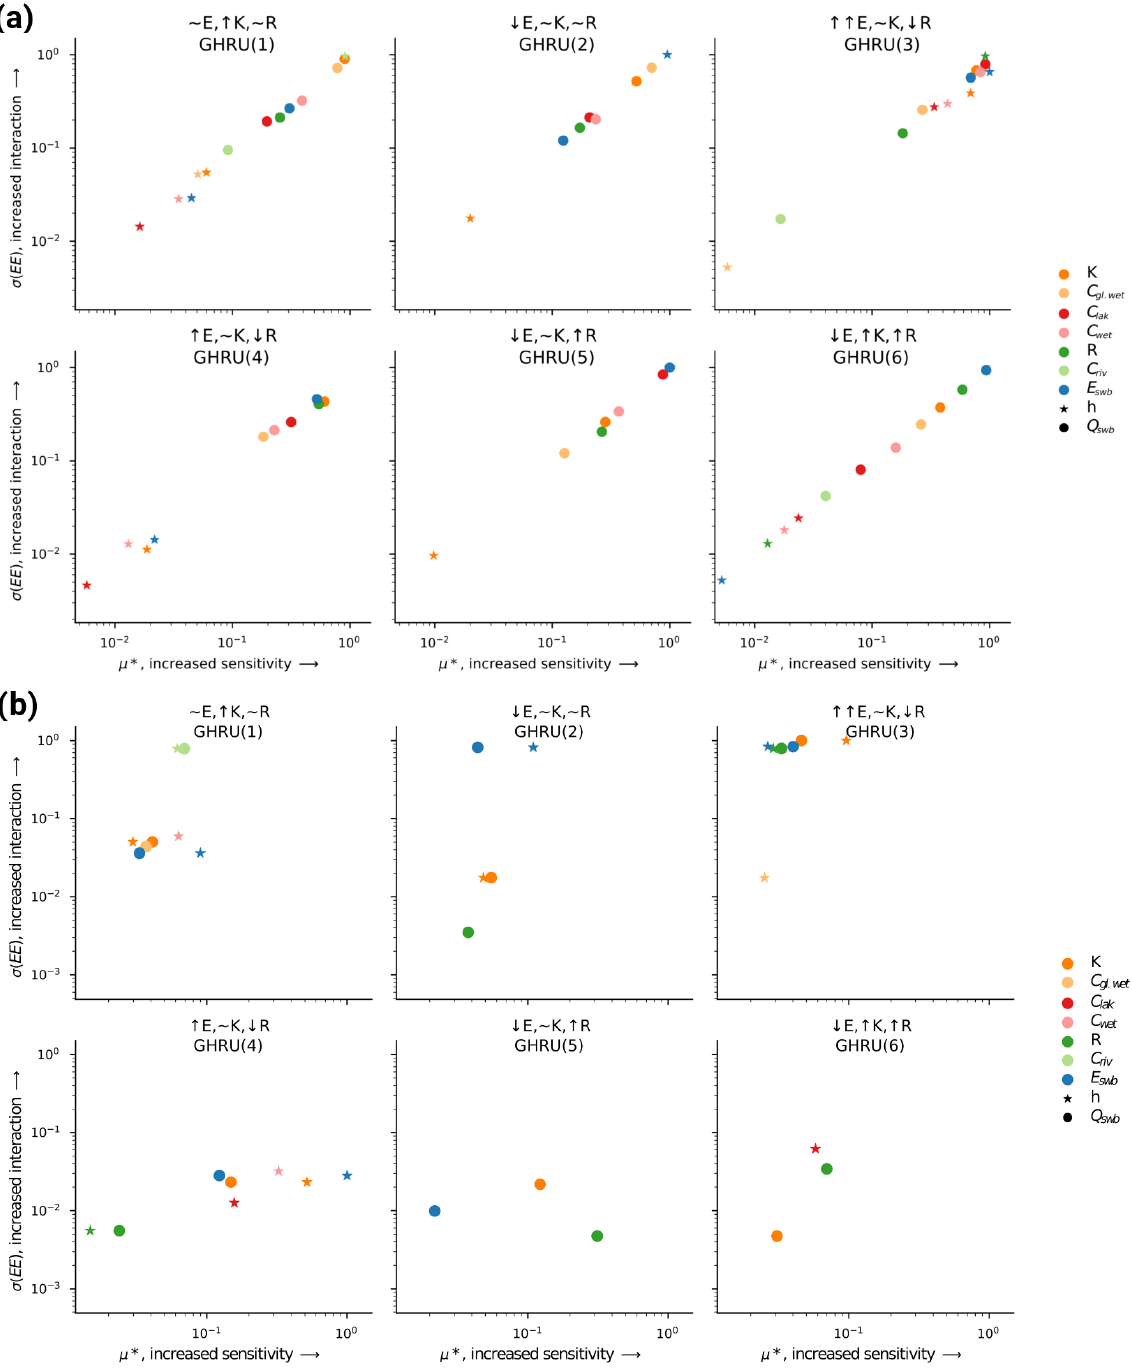
Figure 10. Normalized average sensitivity and parameter interaction per GHRU for h and Q swb (a) . If a parameter is not present the mean sensitivity for that GHRU was close to zero (overlapping CI with zero). Does not include ocean parameter sensitivity. Mean characteristics, their symbols for each GHRU, and the reliability of the sensitivity measure (only µ ∗ not σ ) are shown in Table 2. (b) Only reliable results (after removing overlapping